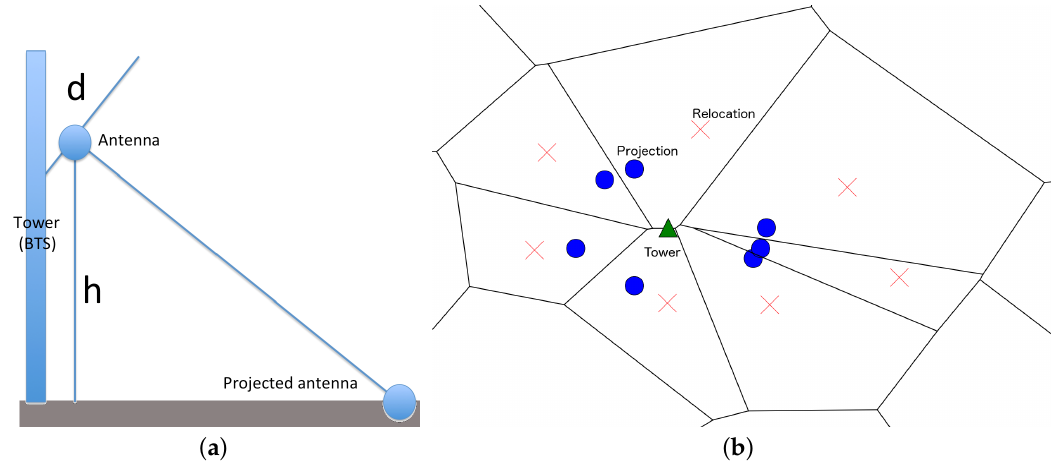
Figure 1. ( a ) Downtilt ( d ) and height ( h ) of an antenna placed in a tower or Base Transceiver Station (BTS) (side-view); ( b ) Sample of the Antenna Virtual Placement (AVP) decoupling process using a Voronoi tessellation to relocate the projections (top-view). The tower (green triangle) projects each antenna to the ground (blue circles), and each projection can be relocated to the centroid of Voronoi polygons (red